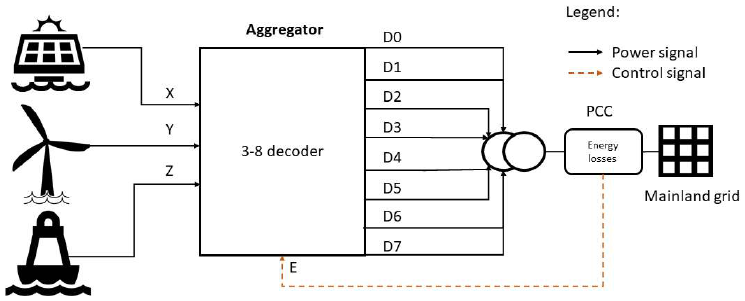
Figure 6. 3-8-line-decoder-based energy losses enabled aggregator. Figure 6 . 3-8-line-decoder-based energy losses enabled aggregator . Table 3. Proposed permutation logic based on 3-8 decoder.